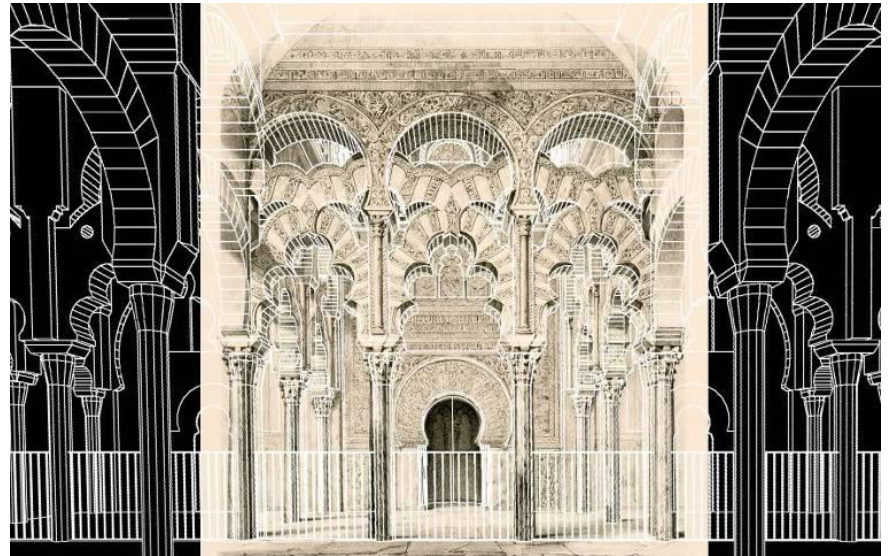
Figure 20. Girault de Prangey (1839): Digital model overlapping the mihrab perspective. Source: Own production.